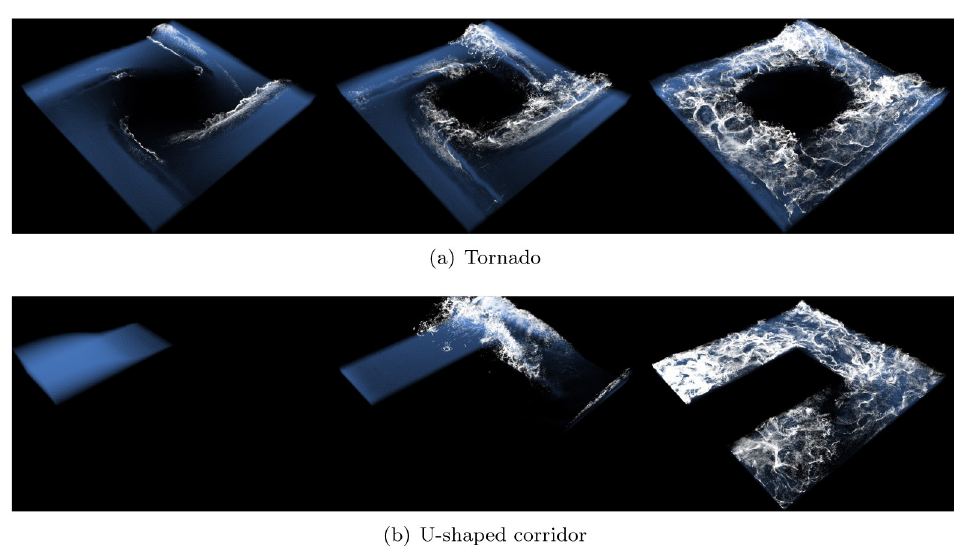
Fig 22. Foam effects with our method. (a) Tornado, (b) U-shaped corridor.